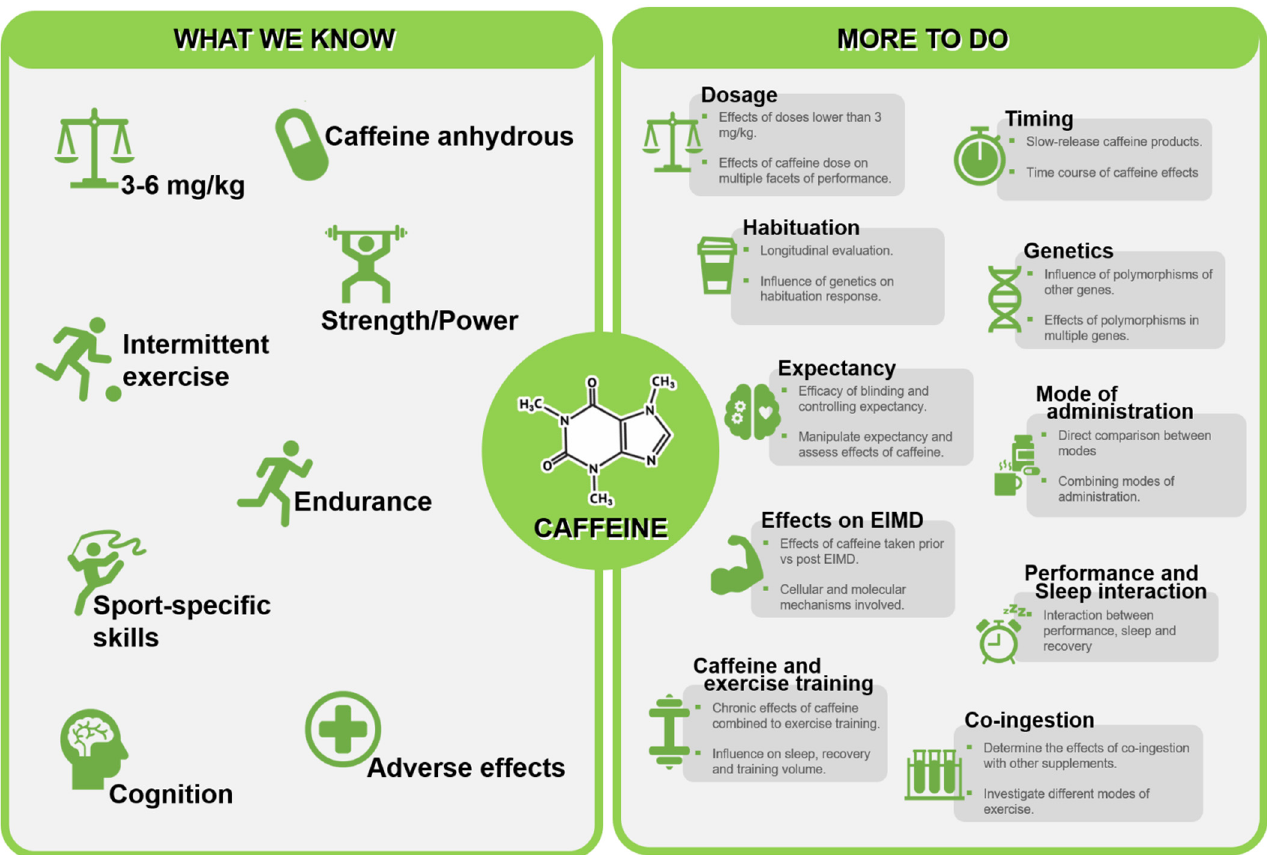
Figure 4. Summary of established effects of caffeine and directions for future investigations. [EIMD = exercise induced muscle damage].